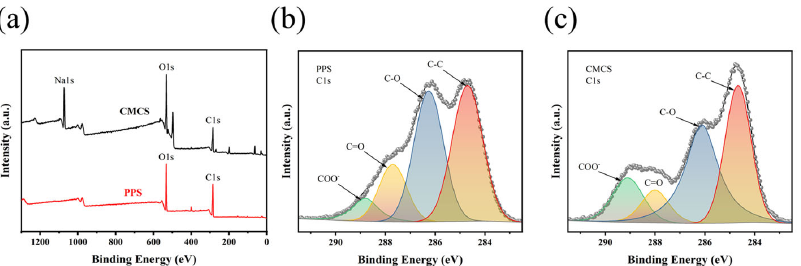
Figure 5. XPS spectra of PPS and CMCS. ( a ) Comparisons of low ‐ resolution mode spectra of PPS and CMCS; ( b ) High ‐ resolution mode XPS spectra of the C1s peaks in PPS; ( c ) High ‐ resolution mode XPS spectra of the C1s peaks in CMCS.